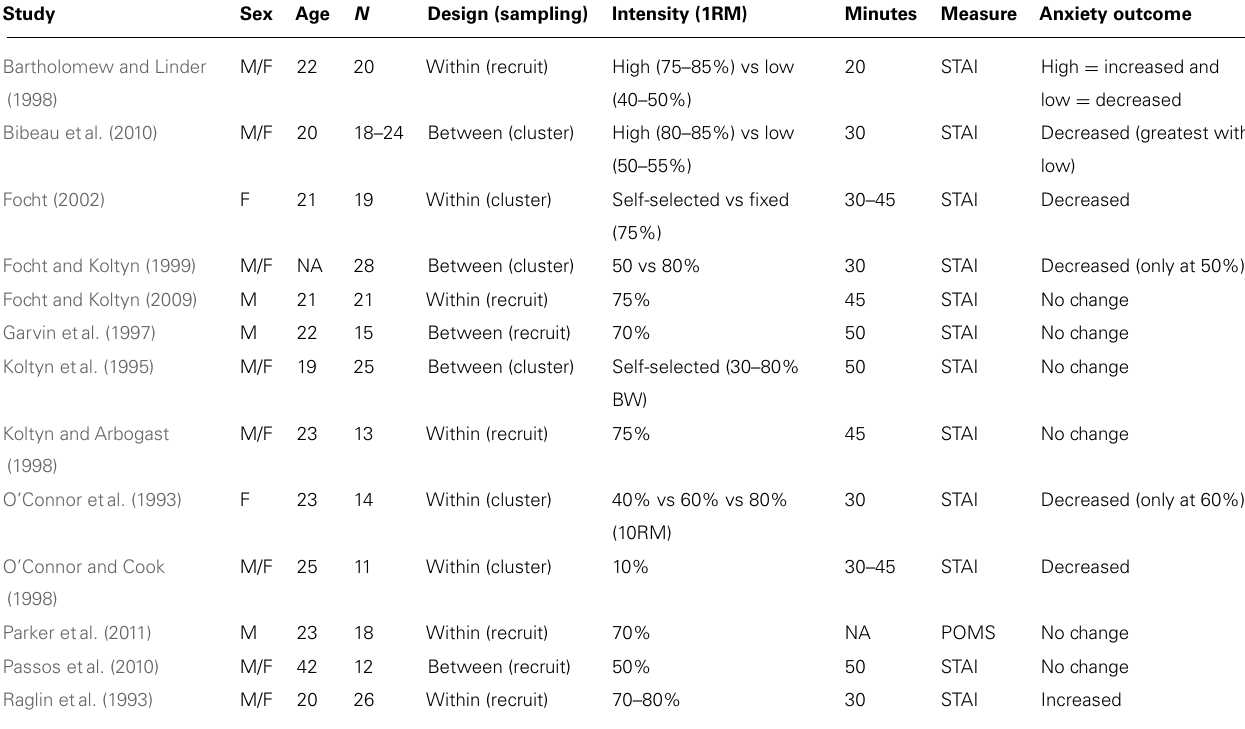
Table 1 |The effects of single-bout resistance exercise on anxiety measures.